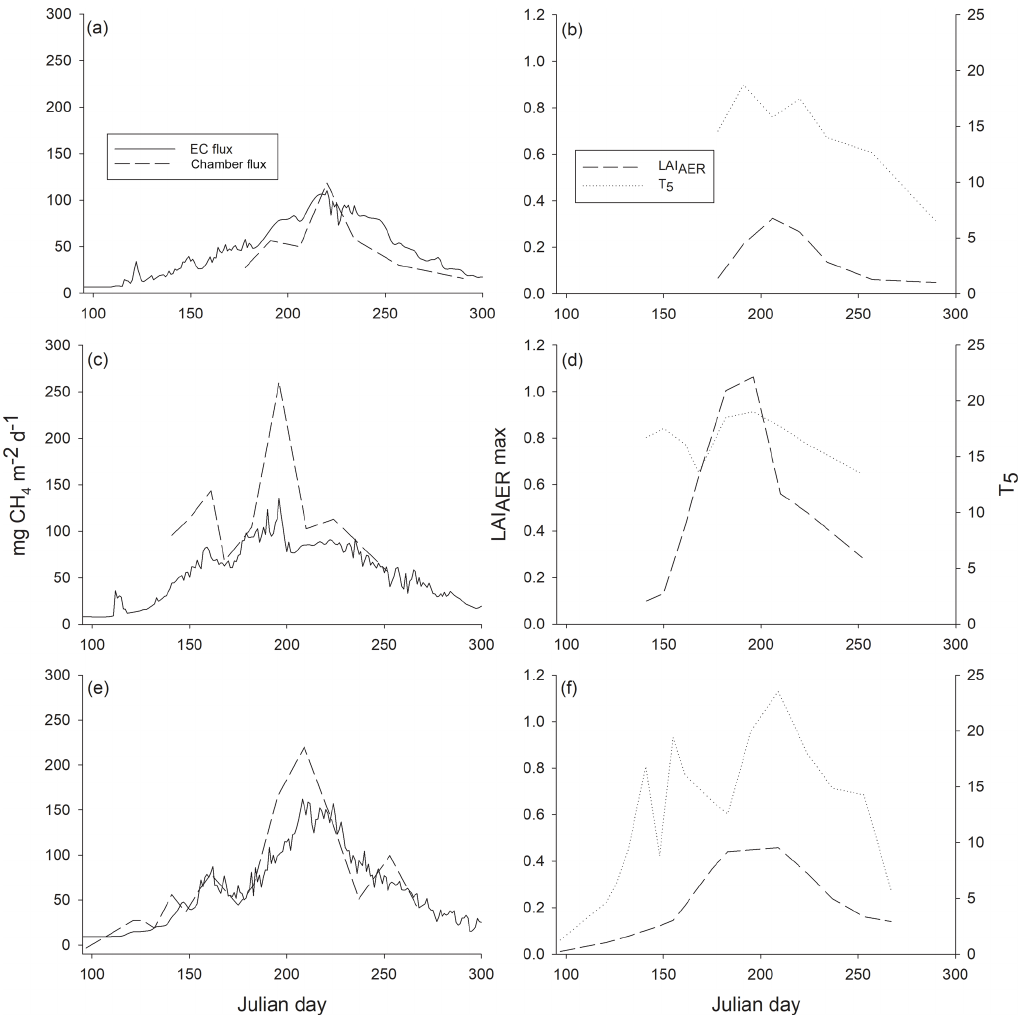
Figure 5. Ecosystem-level methane fluxes measured with the eddy covariance (EC) technique and upscaled from chamber measurements (chamber flux) (a, c, e) and maximum leaf area index of aerenchymatous plant species (LAI AER max) and peat temperature at the depth of 5cm ( T 5 ) (b, d, f) over the growing seasons (a–b) 2012, (c–d) 2013 and (e–f)